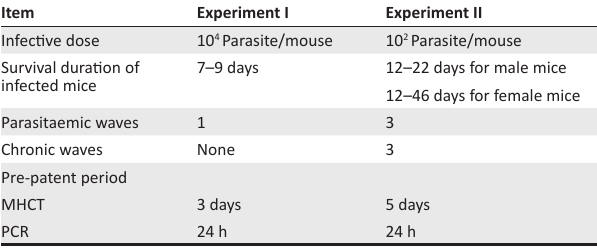
FIG URE 1: Infection in experimentally infected mice. The course of the parasitemia during the period of the experiment I (a) (10 4 infective dose) and experiment II (b) (10 2 infective dose) by micro-haematocrit centrifugation technique. The days post infection is plotted against the approximate no. of parasite in 50 u L blood. The plotted curves represent the different disease patterns obtained in mice during both experiments. TABLE 1: Summary of experimental